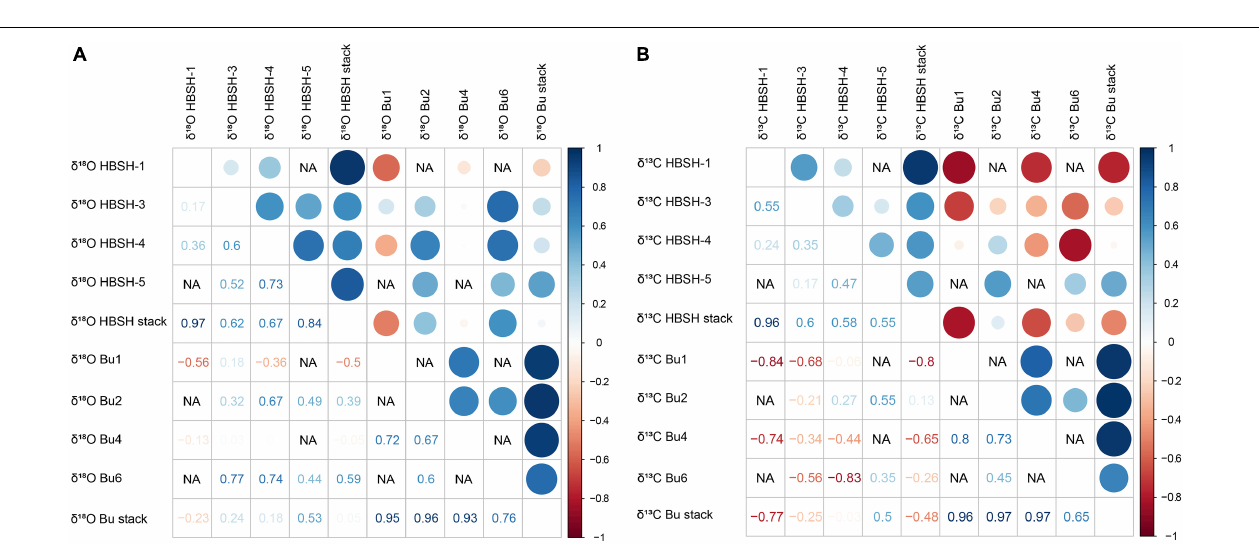
FIGURE 10 | δ 18 O and δ 13 C correlation matrix for centennial means of (A) the four HBSH stalagmites, as well as the two HBSH stacks and (B) the four Holocene stalagmites (Fohlmeister et al., 2012) and two stacks from Bunker Cave (Bu). The size of the circles increases with increasing positive/negative correlation.